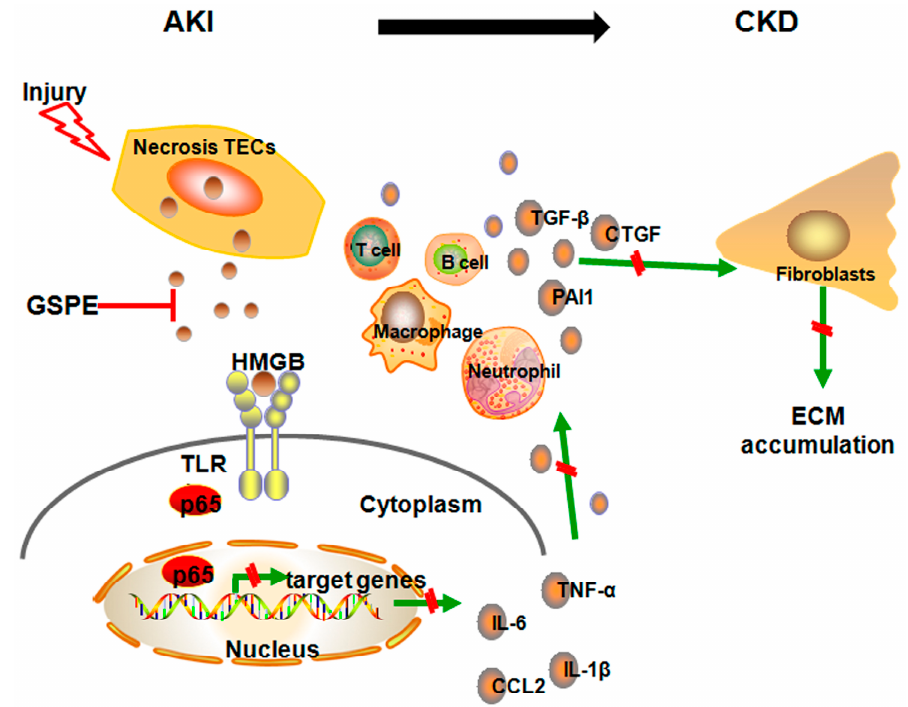
Figure 8. Schematic diagrams illustrating the mechanism by which GSPE protects against IR-induced renal insult by inhibiting the HMGB1-TLR4-p65 pathway. Once tubular epithelial cells suffer IR-induced damage and necrosis, HMGB1 is transported from the nucleus to cytoplasm and released into the extracellular milieu, where they can then bind to TLR4 and promote p65 translocation to the nucleus through autocrine or paracrine signaling. However, all of those effects can be lessened by GSPE. Decreased NF- κ B p65 transcription and translation led to less cytokine and chemokine release, which can trigger a pro-inflammatory response and activate immune cells. Decreased tubulointerstitial inflammation can then inhibit the activation of fibroblasts and mitigate the tubular damage. At the same time, successive treatment with GSPE can also inhibit the HMGB1-TLR4-p65 pathway, which leads to not only less inflammation but also the release of the most potent pro-fibrosis cytokine TGF- β . Green arrows mean promotion and red line means inhibition.